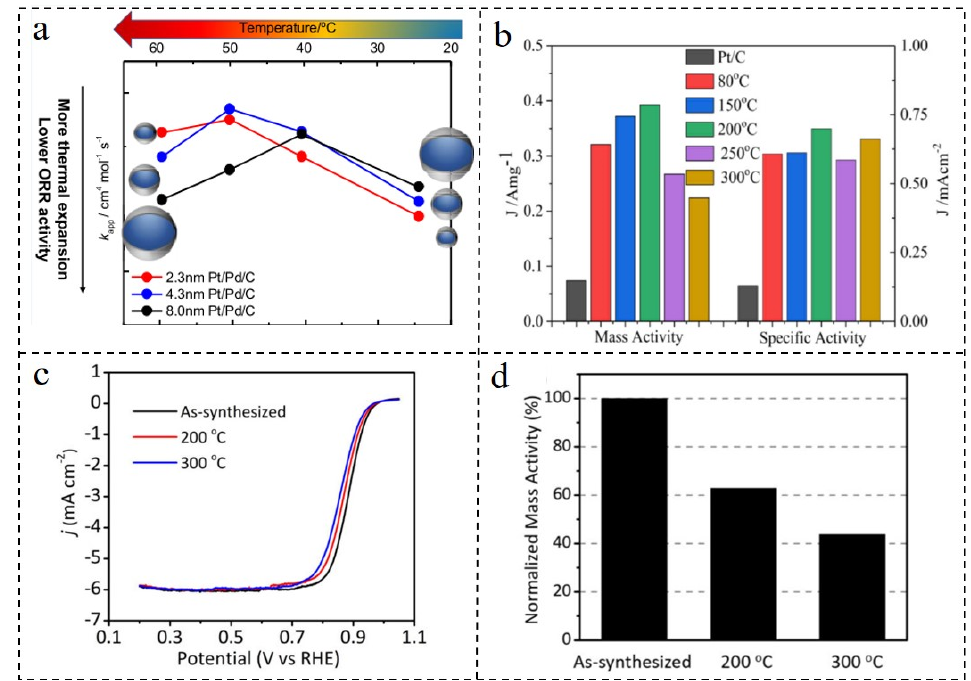
Figure 5. ( a ) Regularity of ORR activity of Pd core with different sizes changing with temperature. Reproduced with permission from [82]. Copyright © 2022, American Chemical Society. ( b ) Mass activity and specific activity at 0.9 V RHE of Pd@PtNi/C catalyst at different annealing temperatures histogram. Reproduced with permission from [83]. Copyright © 2022, Elsevier. Comparison of LSV curves ( c ) and Pt mass activity at 0.9 V RHE ( d ) of as-synthesized and annealed Pd@Pt/C. Reproduced with permission from [84]. Copyright © 2022, Elsevier.